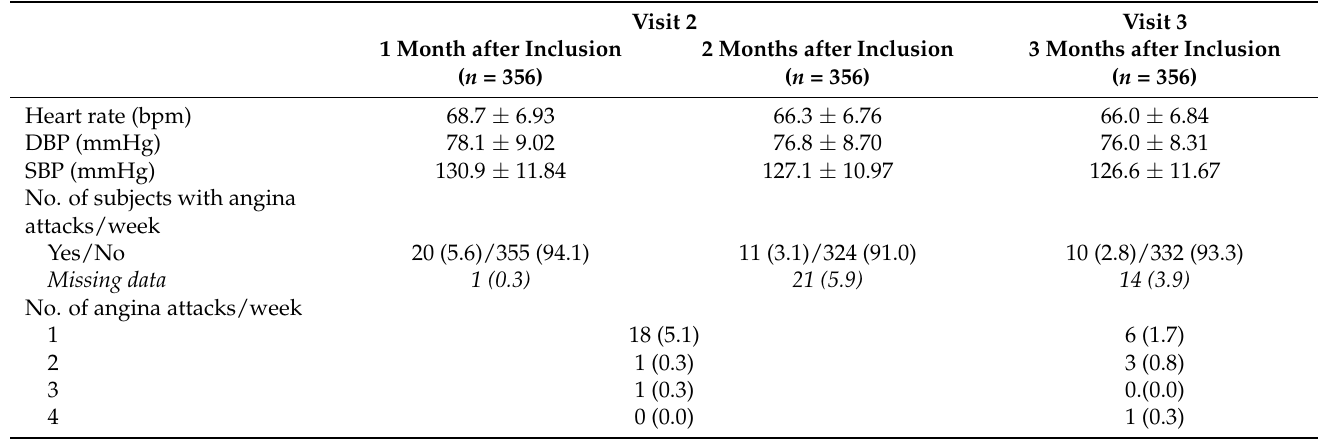
Table 4. Vital signs and angina attacks during the